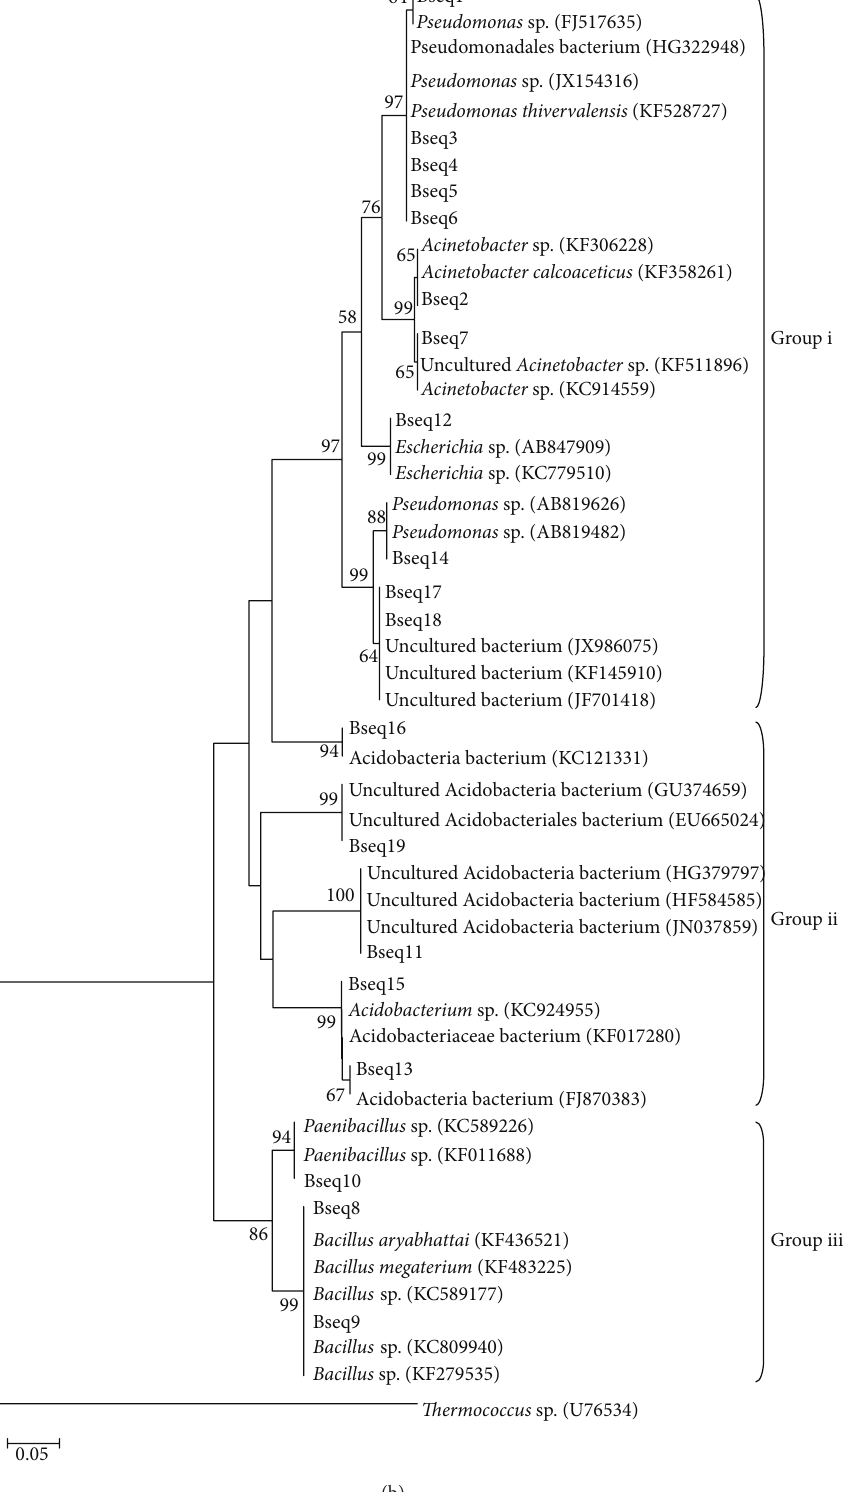
Figure 2: Neighbor-joining phylogenetic tree of fungi and bacteria in the rhizosphere of Pinus tabulaeformis based on their partial ITS and 16SrRNA sequences, respectively. (a) Fungal community composition by recovering rDNA gene sequences from the DGGE gel and conducting phylogenetic analyses. (b) Bacterial community composition by recovering 16SrDNA gene sequences from the DGGE gel and conducting phylogenetic analyses. Only bootstrap analysis was performed using 1,000 replicates. Bootstrap values above 50% were